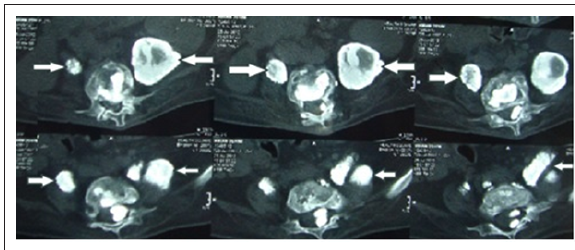
Figure 3. Bilateral calcified psoas abscess marked by white arrows on CT